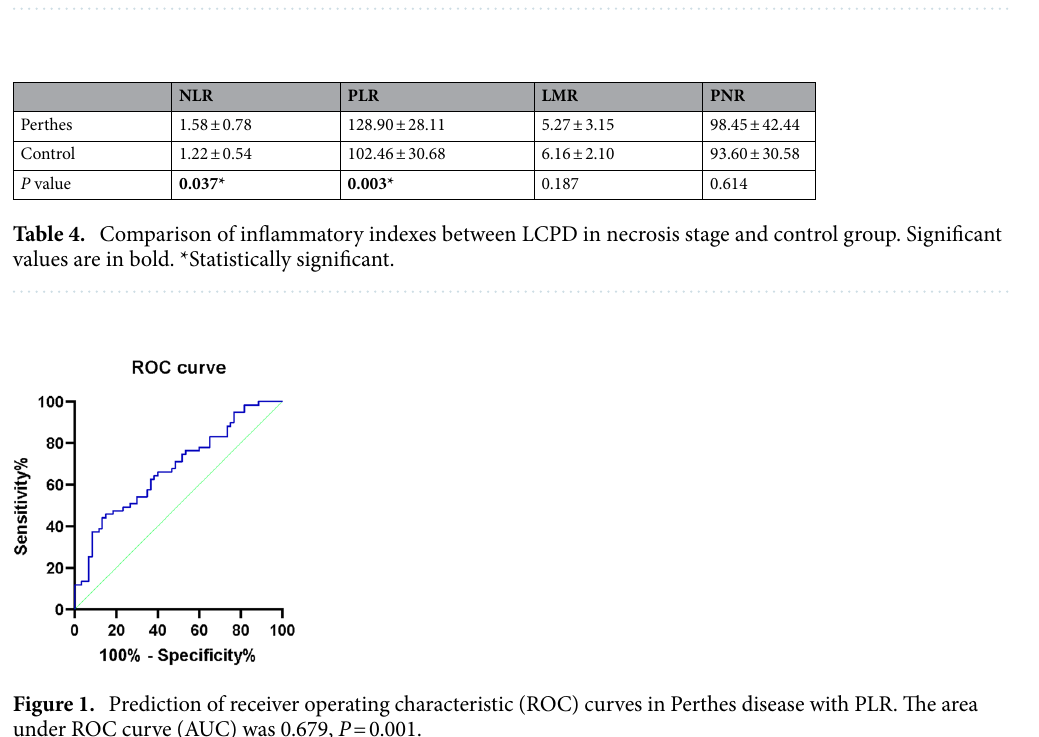
Table 3. Comparison of inflammatory markers in each group. Significant values are in bold. *Statistically significant.